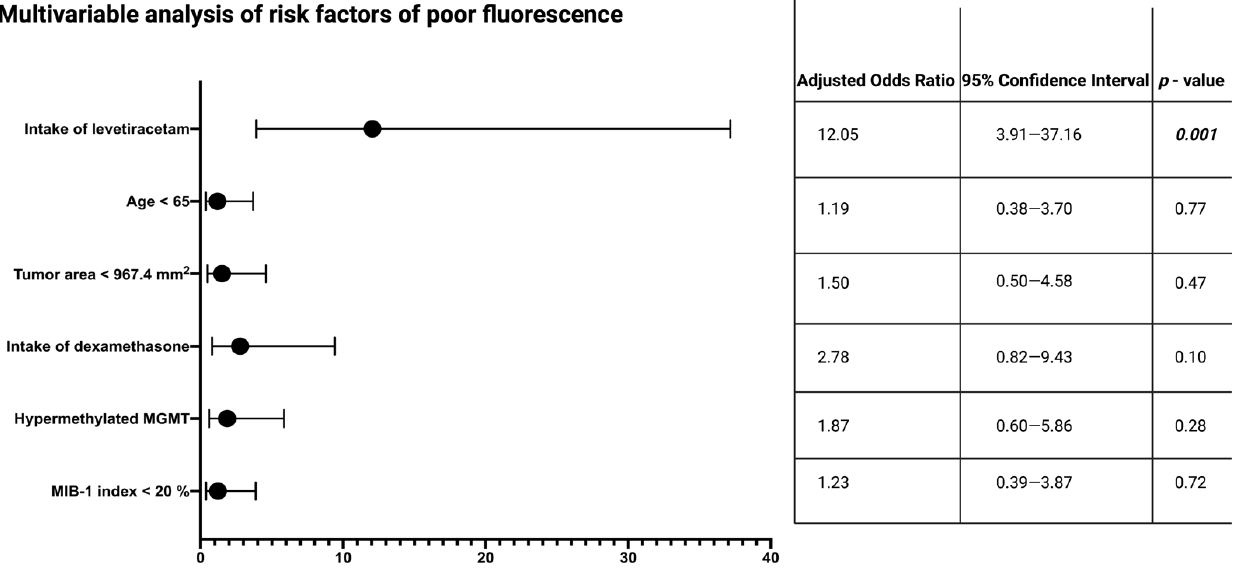
Figure 4. Forest plots from multivariable analysis: intake of levetiracetam is an independent predictor of poor intraoperative 5-ALA fluorescence quality in surgery for IDH1 wild-type glioblastoma. p -values in bold and italics display statistically significant results.